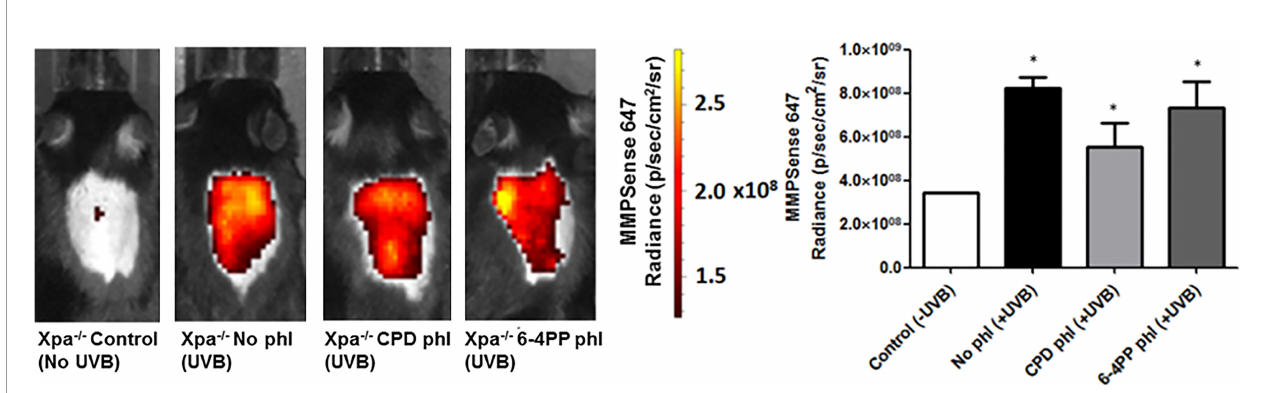
FIGURE 4 | In vivo effects of keratinocyte-speci fi c photorepair of CPDs or 6-4PPs in Xpa-/- mice after a single, high UVB irradiation dose. MMPsense was used to measure in vivo the presence of MMPs in mice skin 24 h after UVB irradiation, n=2. Radiance quanti fi cations of fl uorescent and chemiluminescent probes were performed in the central region of the mice exposed dorsal skin with equivalent sized regions of interest using Living Image 4.0 software. Asterisks (*) indicate a statistically signi fi cant difference between the designated group and negative, Xpa-/- non-irradiated,